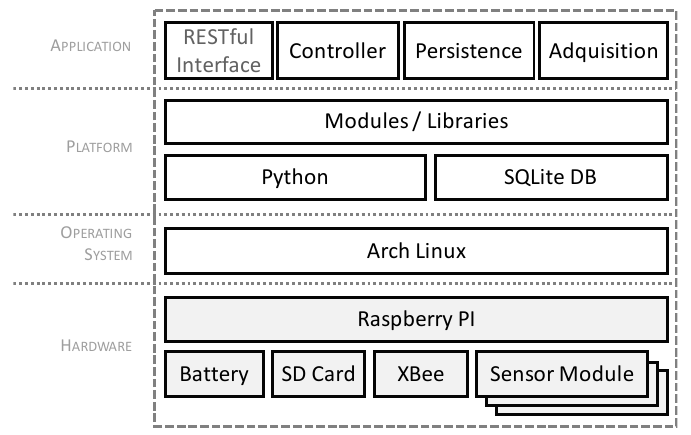
Figure 11. Layered architecture of the prototype. Table 5. List of the software components and versions used.